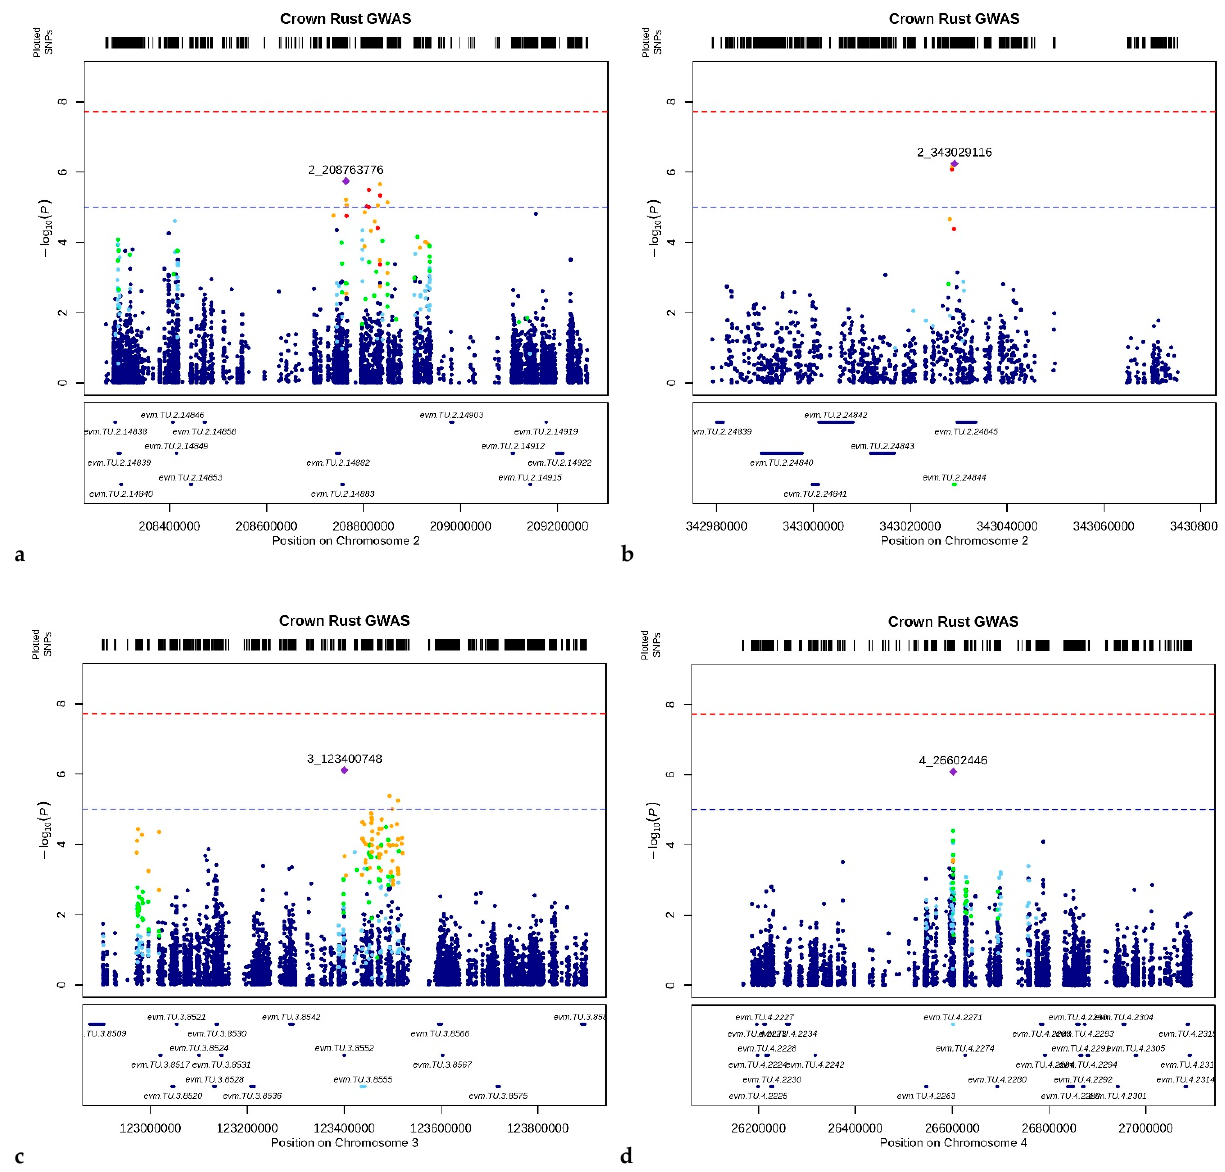
Table 3. Summary results of GCTA. Additive (A), phenotypic (P), residuals (e) variance (V) and SNP heritability ( h 2SNP ) explained for crown rust (CR) and brown rust (BR) resistance. Numbers between brackets refer to standard deviation.